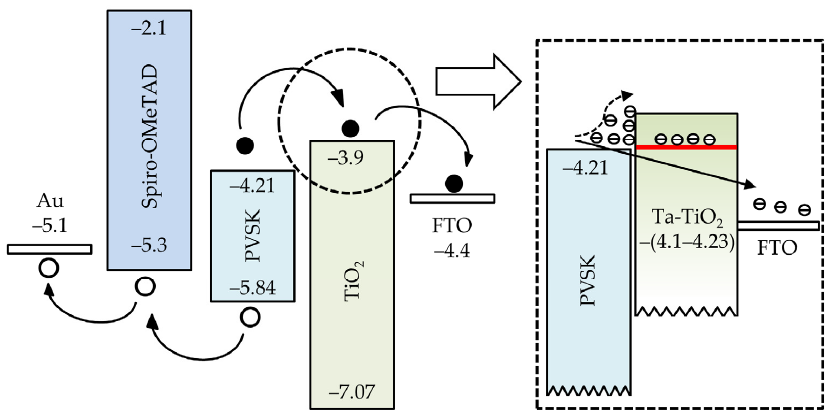
Figure 7. Isolated energy band diagram of each material involved in a TiO 2 ETL-based PSC. The inset indicates the interfaces of perovskite/TiO 2 and perovskite/Ta-doped TiO 2